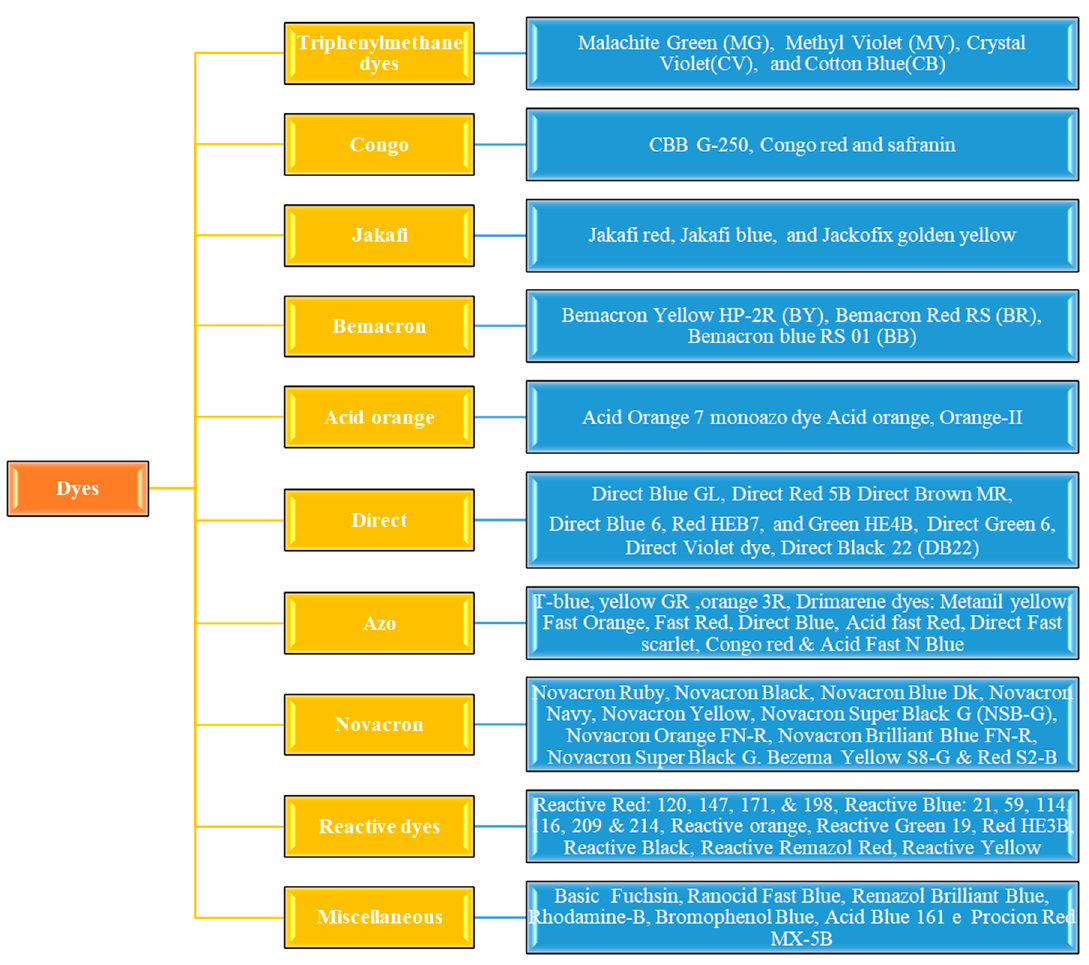
Figure 2. Dyes along with their representative members.